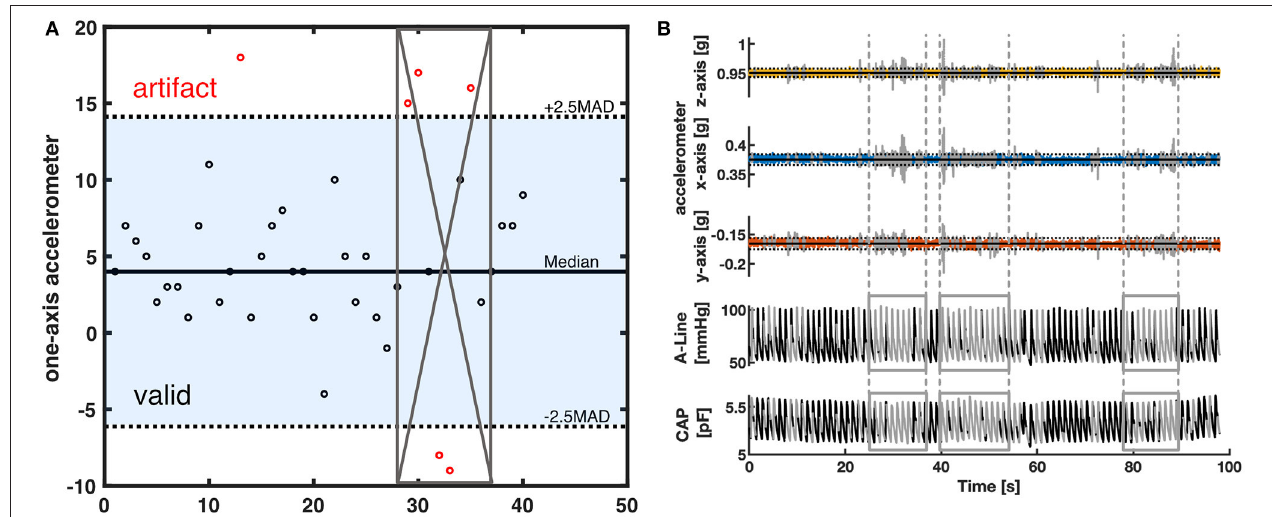
FIGURE 2 | The artifact removal procedure using accelerometer data (A) Illustration of MAD filter and moving window. The horizontal solid line is the median value of the accelerometer dataset. The dotted lines are the 2.5-scaled MAD. Black circles represent the data within 2.5-scaled MAD. Red circles are considered outliers. The gray crossed area represents the invalid segment after a 50 percent threshold moving window with a window size of 8. (B) A representative segment showing how the data was filtered with a MAD filter and the moving window. The top three rows are the 3-axis of the accelerometer data. The horizontal solid line represents the median in each axis. The dotted lines are the 2.5-scaled MAD of each axis. The bottom two rows represent the corresponding A-Line and the CAP sensor data. The signal section colored gray and defined by the vertical lines was categorized as having excessive artifacts from the accelerometer data and thus